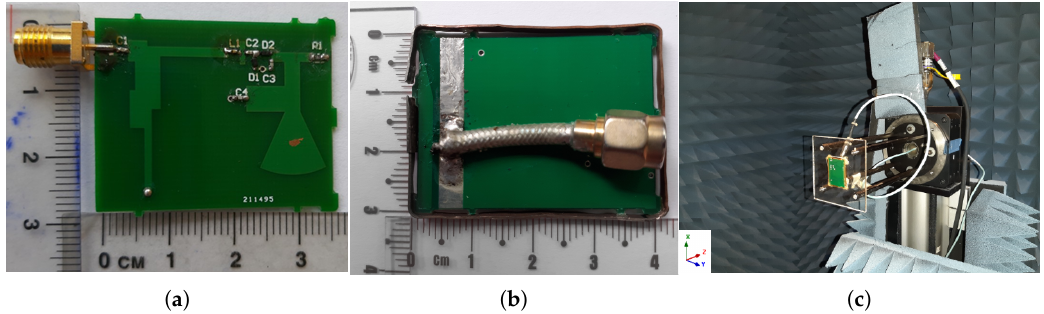
Figure 10. Realization of ( a ) rectifier, ( b ) antenna and ( c ) measurement